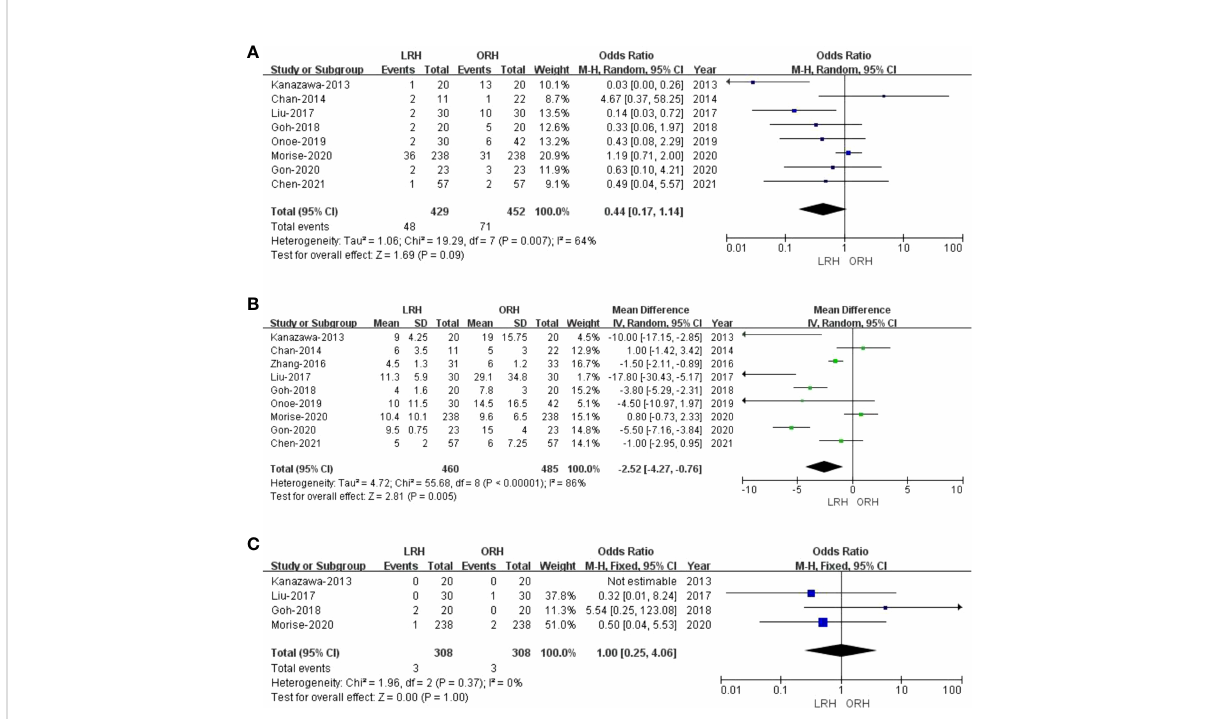
FIGURE 3 Forest plot of comparison of LRH versus ORH for postoperative outcomes of survivors. (A) , Forest plot for overall complication rates; (B) , Forest plot for the length of stay; (C) , Forest plot for 90-day mortality.